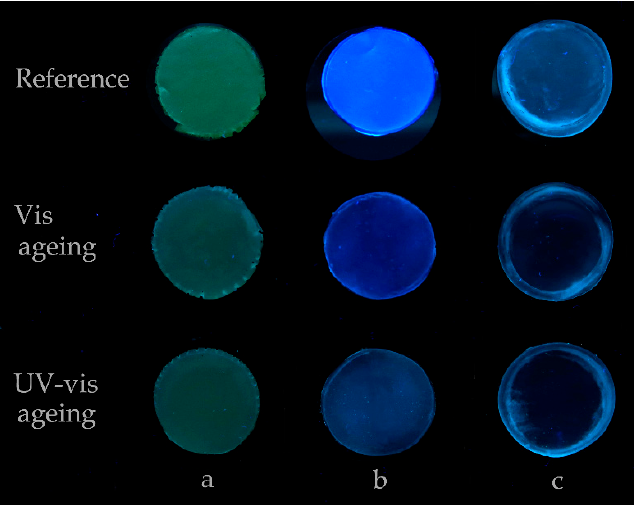
Figure 11. Comparison of the fluorescence of the samples before and after the exposure to UV-vis radiation for 240 h. ( a ): recent beeswax, ( b ): Permulgin 3274, ( c ): hydrogenated Permulgin 3274. Photograph acquired under UV light (lamp: OSRAM L18 W/73). Table 4. Total acid number before and after the UV-vis ageing experiment. The data are expressed as mean ± standard deviation.